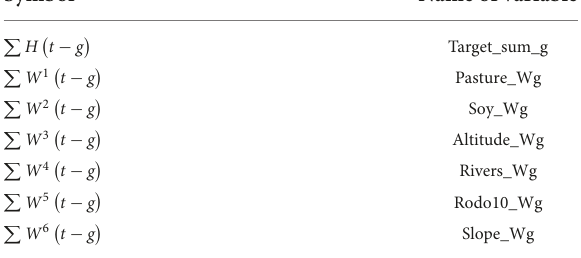
TABLE 3 Time-dependent features and their